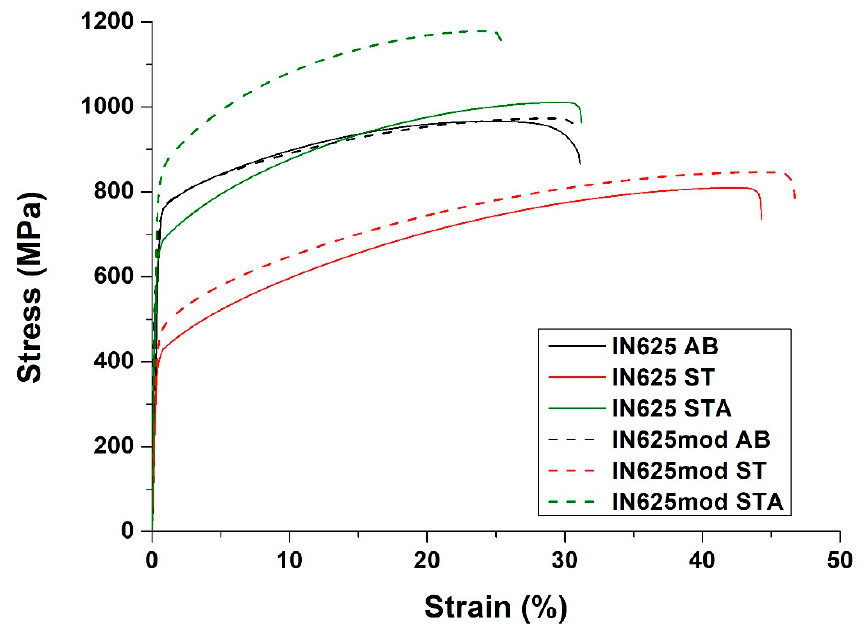
Figure A4. Representative plots of the tensile stress-strain curves of the IN625 and IN625mod conditions.